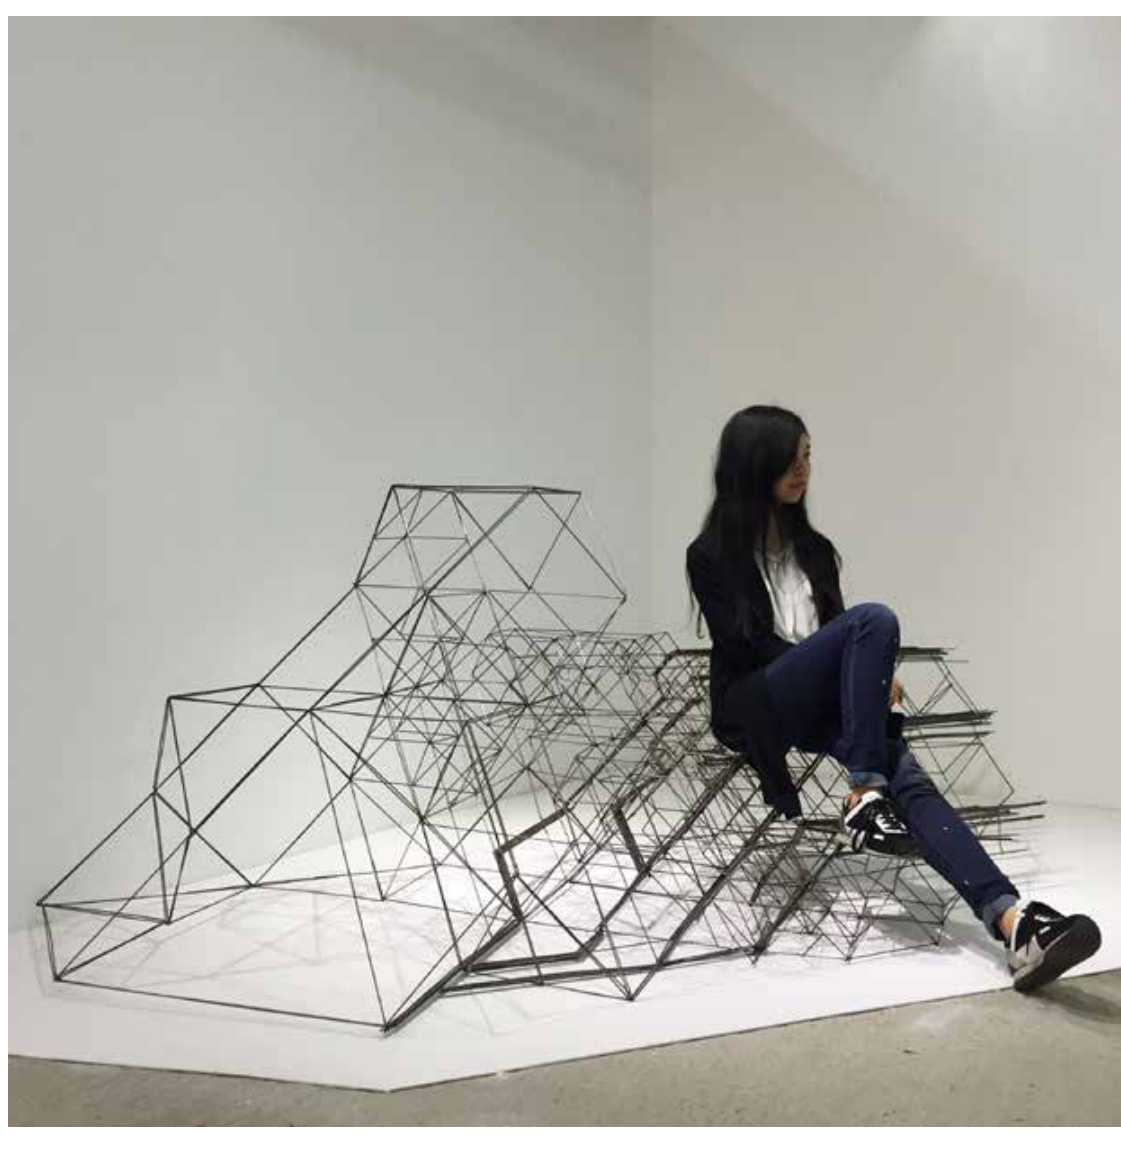
Figure 9 (left): Structural Slip (2018). Ceramic. Design: Daniel Widrig, Guan Lee, Adam Holloway. Team : Vittoria Fusco, Banni Liang, Dan Liang, Mingyu Wei. Source: